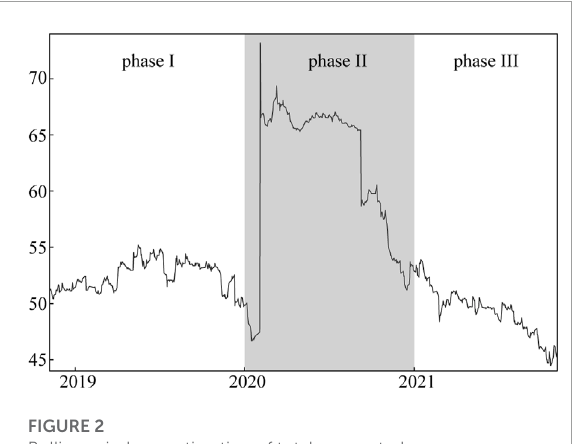
FIGURE 2 Rolling-windows estimation of total